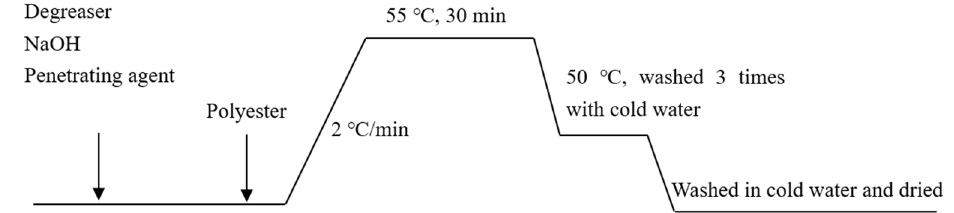
Figure 2. Pretreatment process of polyester.